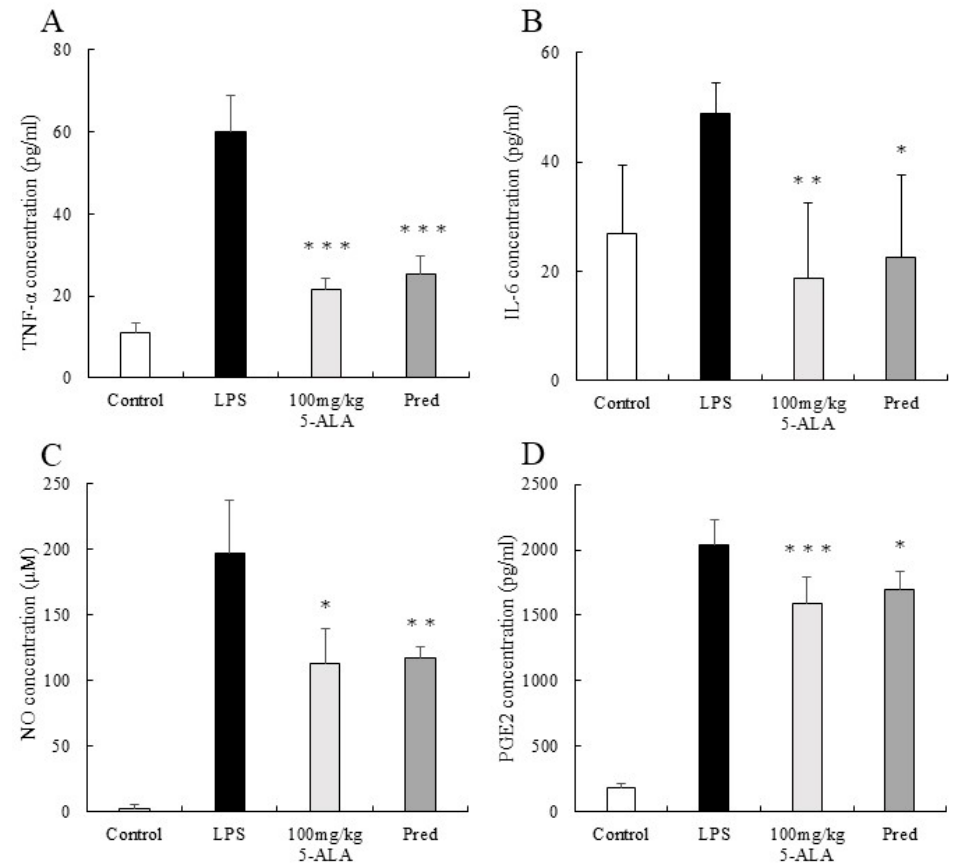
Figure 3. 5-ALA suppressed TNF- α ( A ), IL-6 ( B ), NO ( C ), and PGE2 ( D ) concentrations. Each value rep- resents the mean ± SD ( n = 5). * p < 0.05, ** p < 0.01, and *** p < 0.001, compared with the LPS group. TNF- α , tumor necrosis factor- α ; IL-6, interleukin-6; NO, nitric oxide; PGE2, prostaglandin